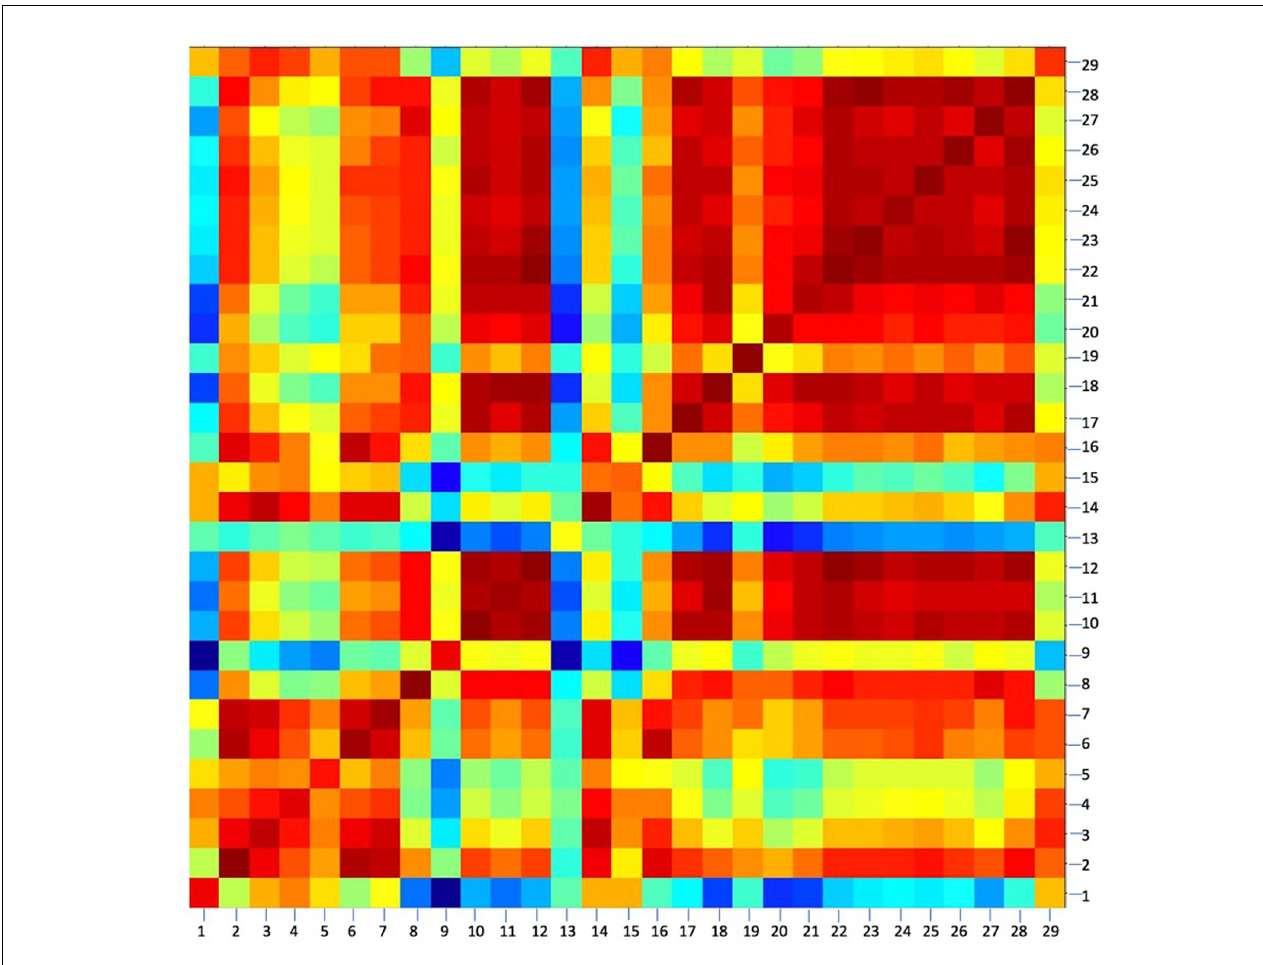
FIGURE 2 | A composite correlation index (CCI) of 29 bacterial strains identified as Bacillus firmus ( ≥ 98.7% 16S rRNA sequence similarity). Strain-level variations were seen using CCI clustering, although they are 100% similar based on 16S rRNA sequences. At least two spectra were used to represent each strain’s mass spectral profile ( ≥ 2.7 log score). MALDI-TOF Biotyper Compass Explorer V4.1, Euclidean distance, and 10 intervals were used. Distances between mass spectra are represented as a color spectrum ranging from red, high similarity, to blue, low similarity.